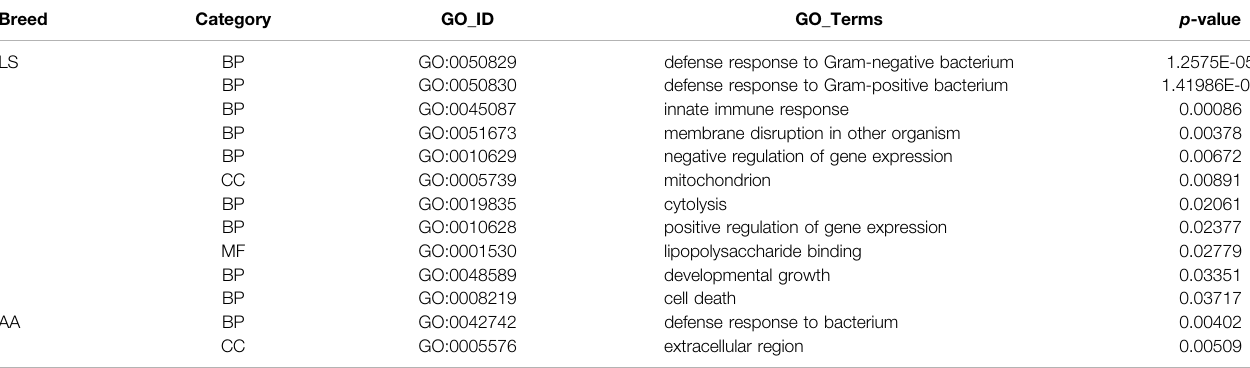
TABLE 4 | GO clusters of genes located on TAD boundaries of AA and LS chicken breast muscles. Breed